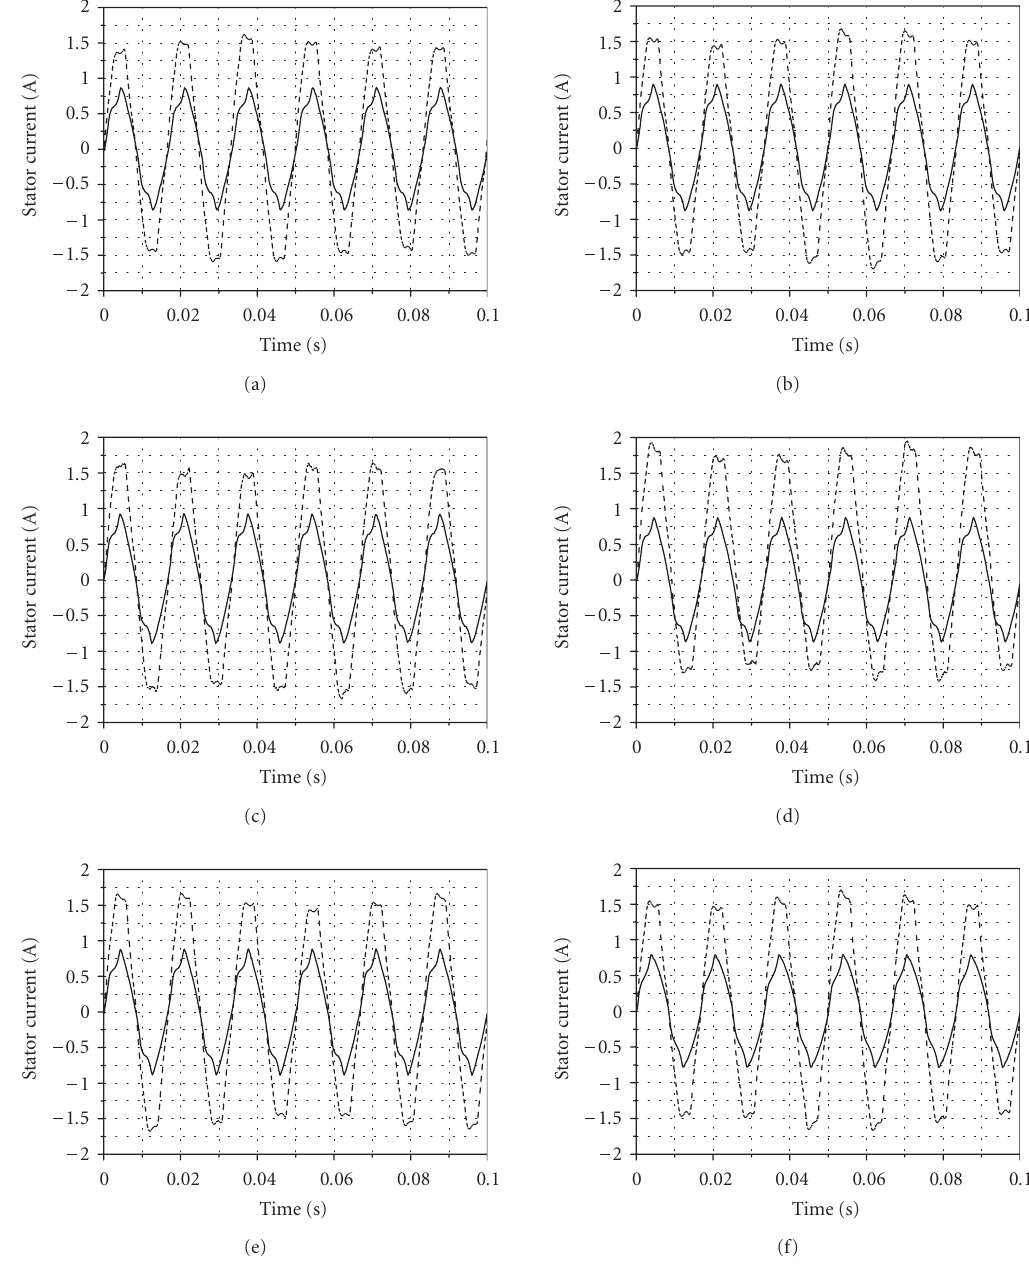
Figure 6: Typical motors stator current signals under no-load condition (solid line) and full-load condition (dotted line). (a) Normal condition, (b) bowed rotor, (c) broken rotor bar, (d) faulty bearing (outer race), (e) rotor unbalance, (f) rotor misalignment.